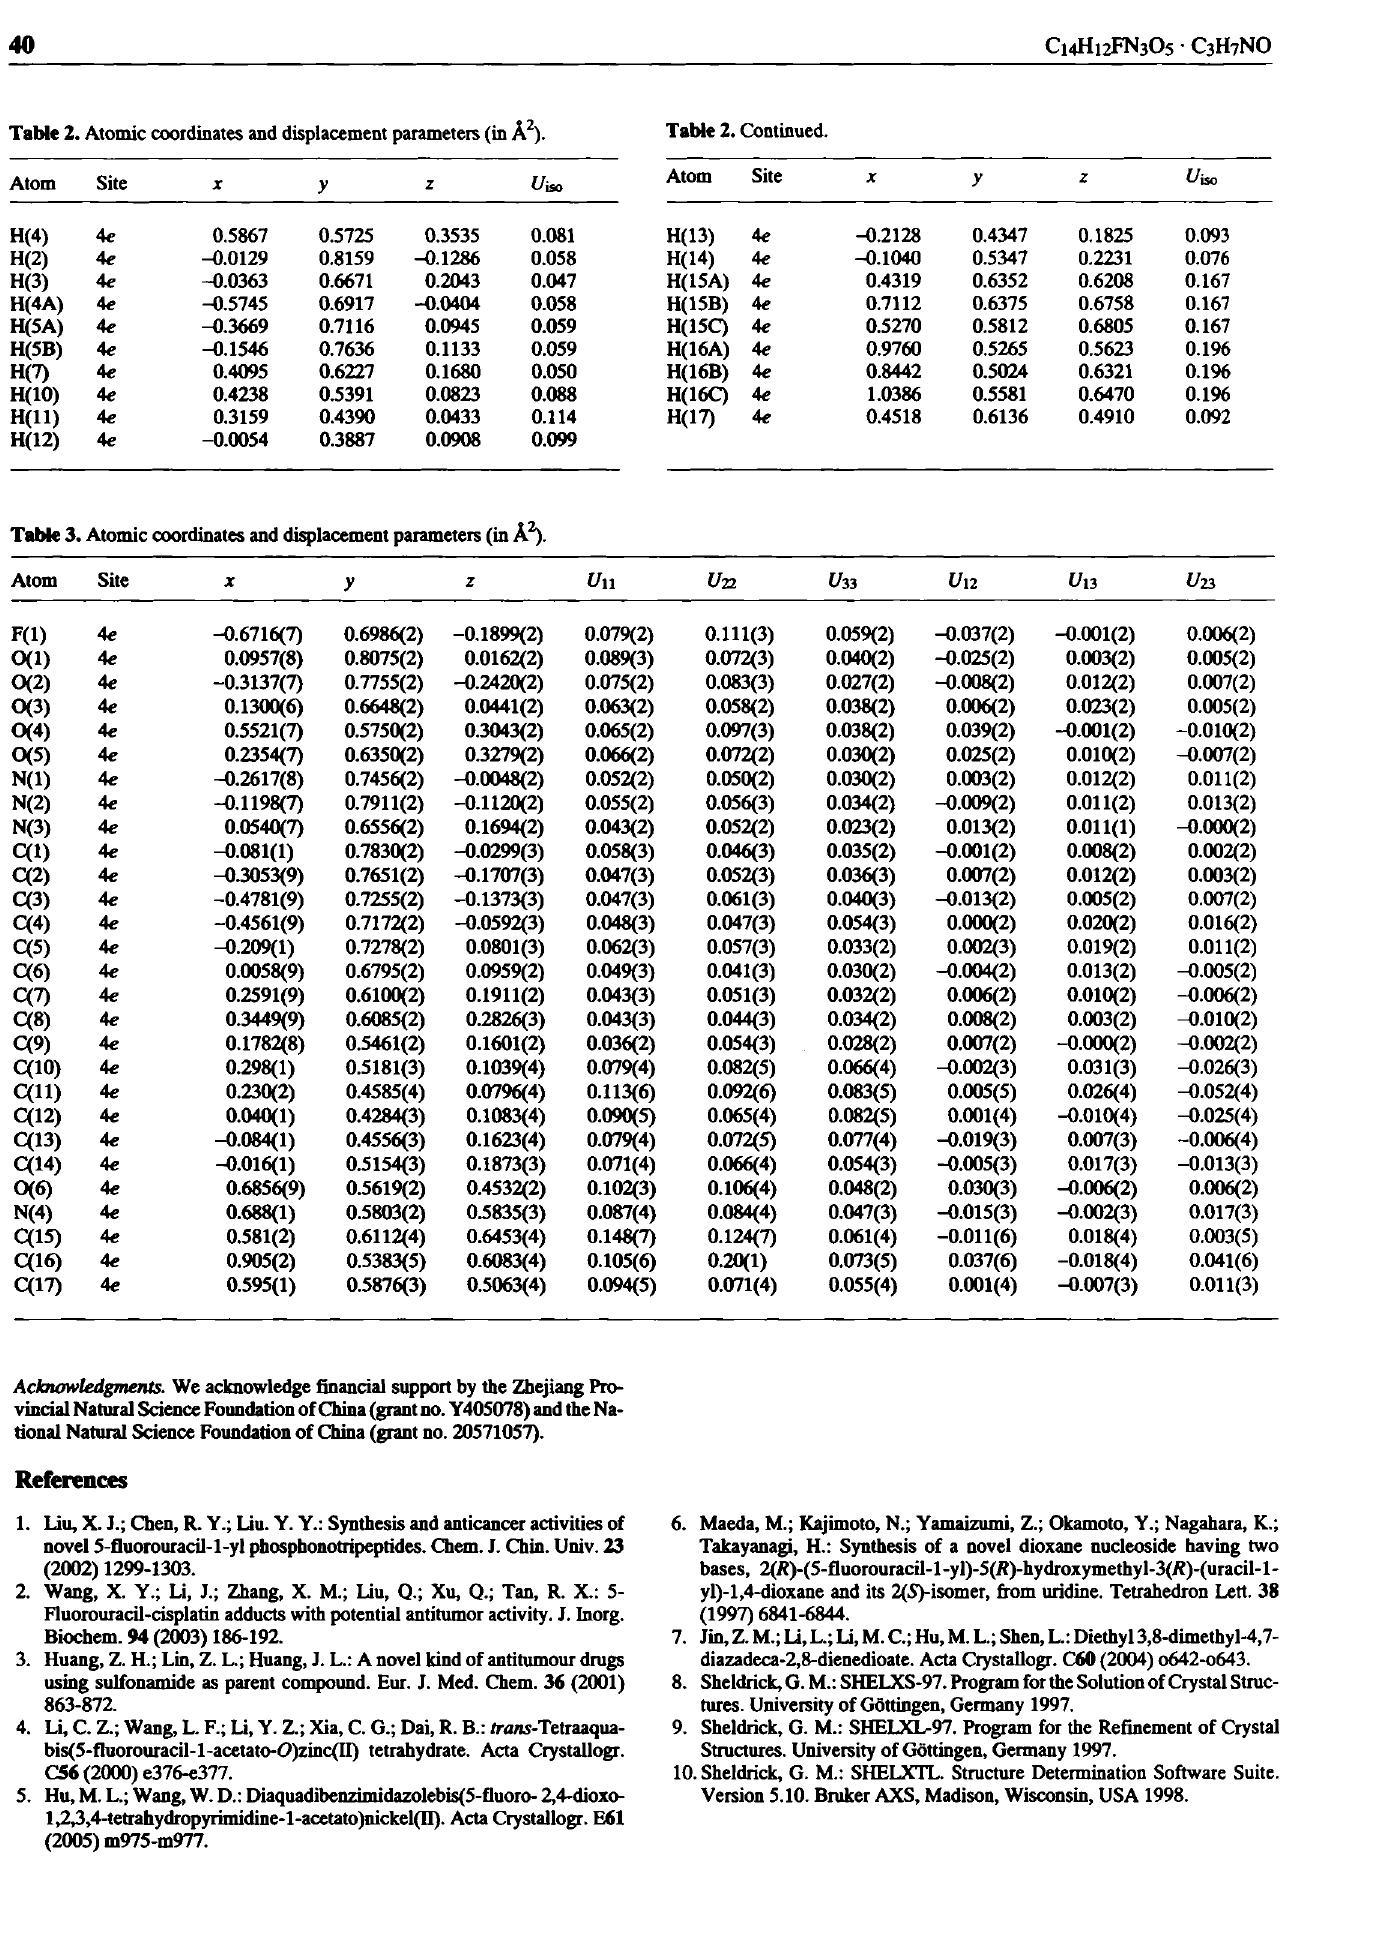
Table 2. Atomic coordinates and displacement parameters (in Ä 2 ).